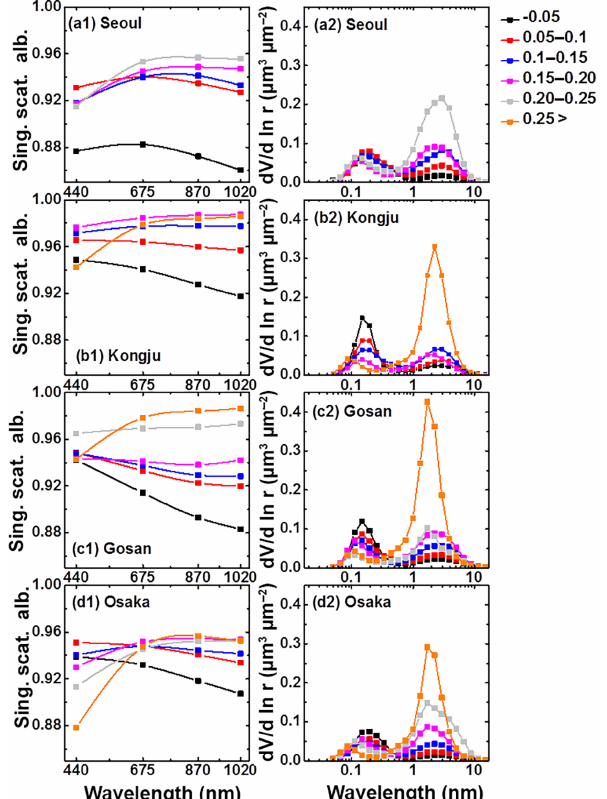
Figure 9. Average value of the SSA and the volume particle size distributions derived from the AERONET sun–sky radiometer mea- surements for each of the six groups considered in this study: group 1 (black), group 2 (red), group 3 (blue), group 4 (pink), group 5 (gray), and group 6